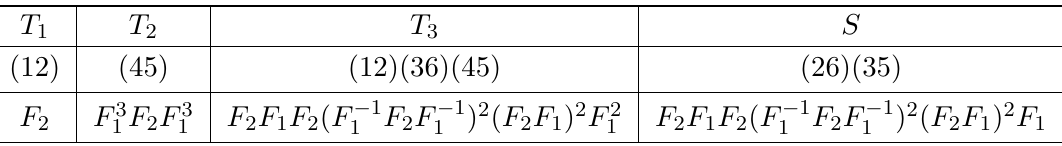
Table 1 . The relationship between the two sets of generators T 1 , 2 , 3 , S and F 1 , 2 of the finite Seigel modular group S 6